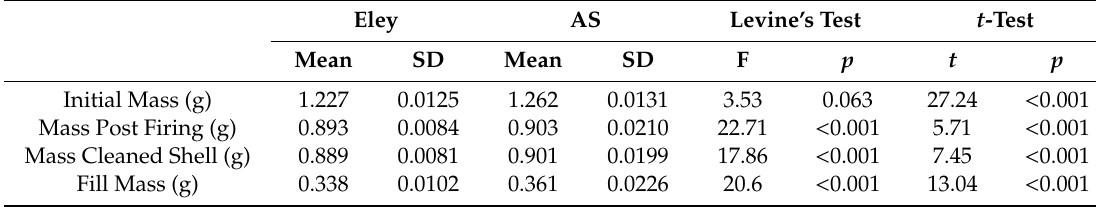
Figure 10. Initial mass of unfired cartridges illustrating that AS-head-stamped cartridges were heavier than E-head-stamped cartridges.